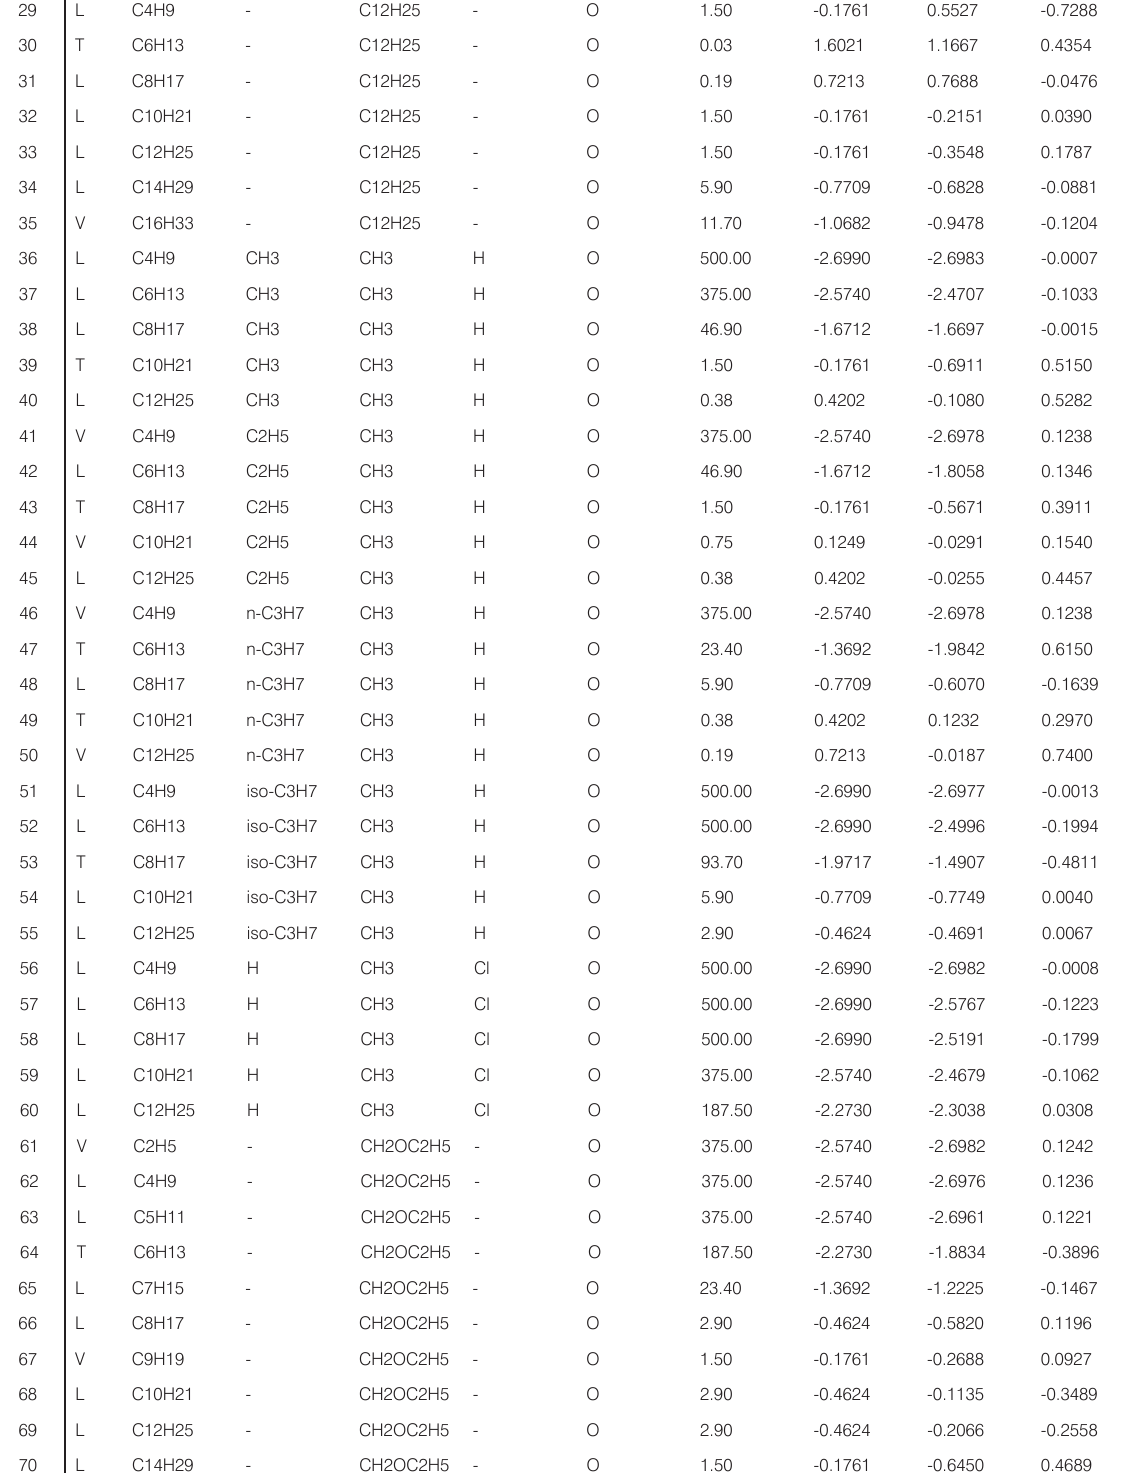
Table 1S continued. Experimental and predicted logarithms of reciprocal of the minimal inhibitory concentrations, log 1/MIC along with the errors between those two